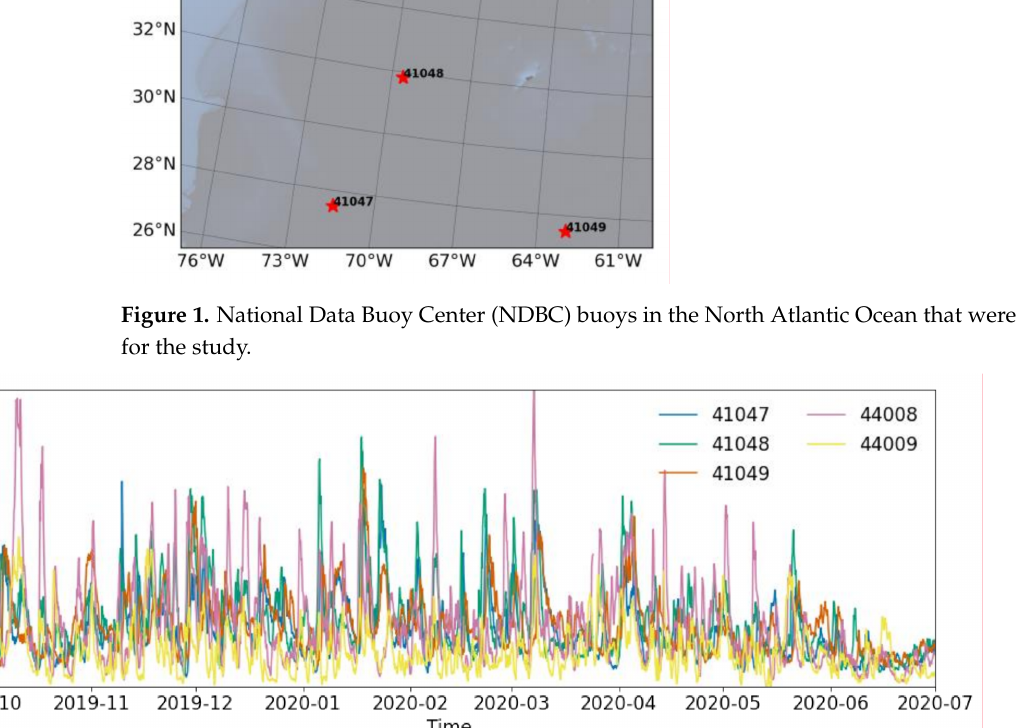
Figure 2. Time series of the significant wave height Hs (meters) of the NDBC buoys